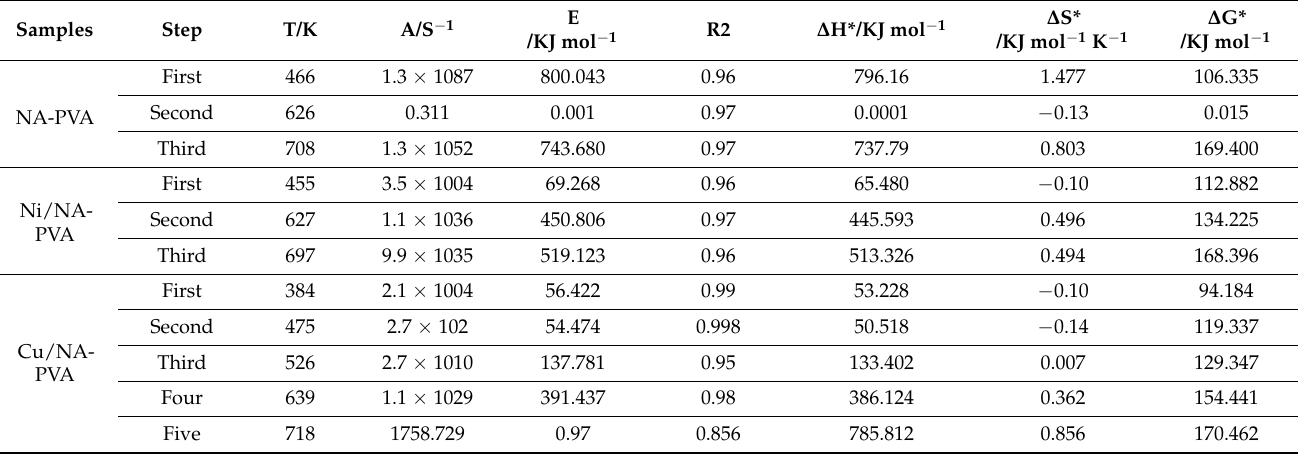
Table 2. The Kinetic Parameters of NA-PVA, NiII and Cu/NA-PVA by Horowitz Metzger program.